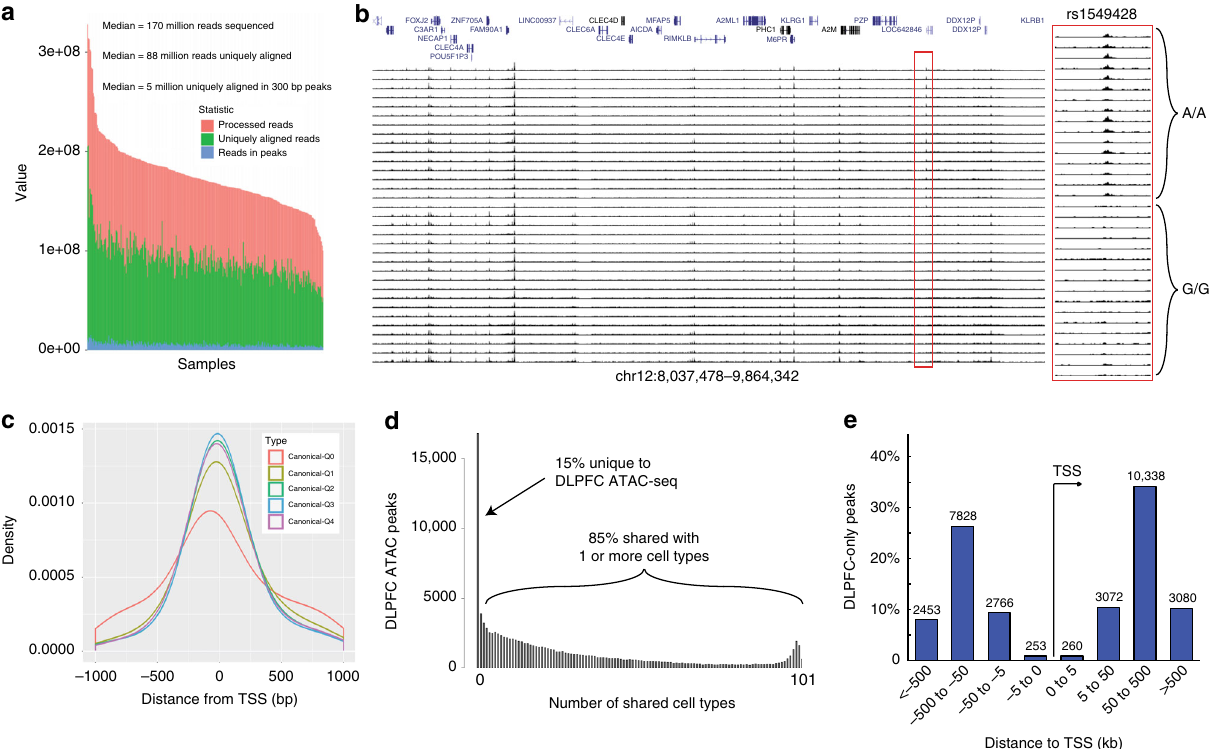
Fig. 1 ATAC-seq on frozen DLPFC samples. a Sequencing statistics from all libraries ( N = 288) show largely similar total number of reads (pink), uniquely aligning reads (green), and reads that map to ATAC-seq peaks (blue). b Individual brain ATAC-seq data in a representative genomic region showing largely congruent identi fi cation of regions of open chromatin. Some samples have lower signal to noise (correlated with covariates like postmortem interval and RNA integrity number). Region in red is a chromatin QTL, note lower signal for individuals with GG genotype vs. AA genotype. c Open chromatin in relation to transcription start sites (TSS). The TSS is at zero, right is inward in the direction of transcription, and left is outward from the gene. Density curves for all known GENCODE v25 transcripts (one principal transcript per protein-coding gene). Colored curves show different expression levels in DLPFC: Q0 = no expression, Q1 – Q4 = lowest to highest expression quartiles. d Number of DLPFC ATAC-seq peaks that overlap with putative